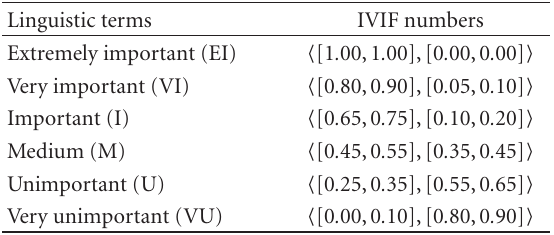
Table 3: Importance weight as linguistic variables. Linguistic